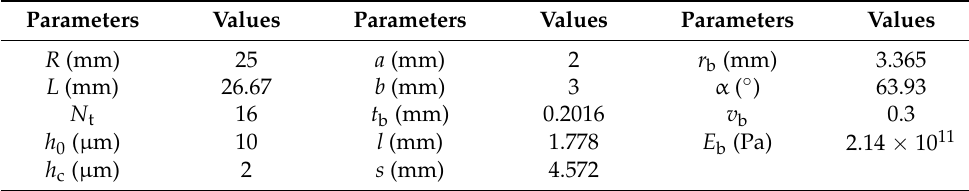
Table 1. Geometric structure and mechanical performance parameters. Parameters